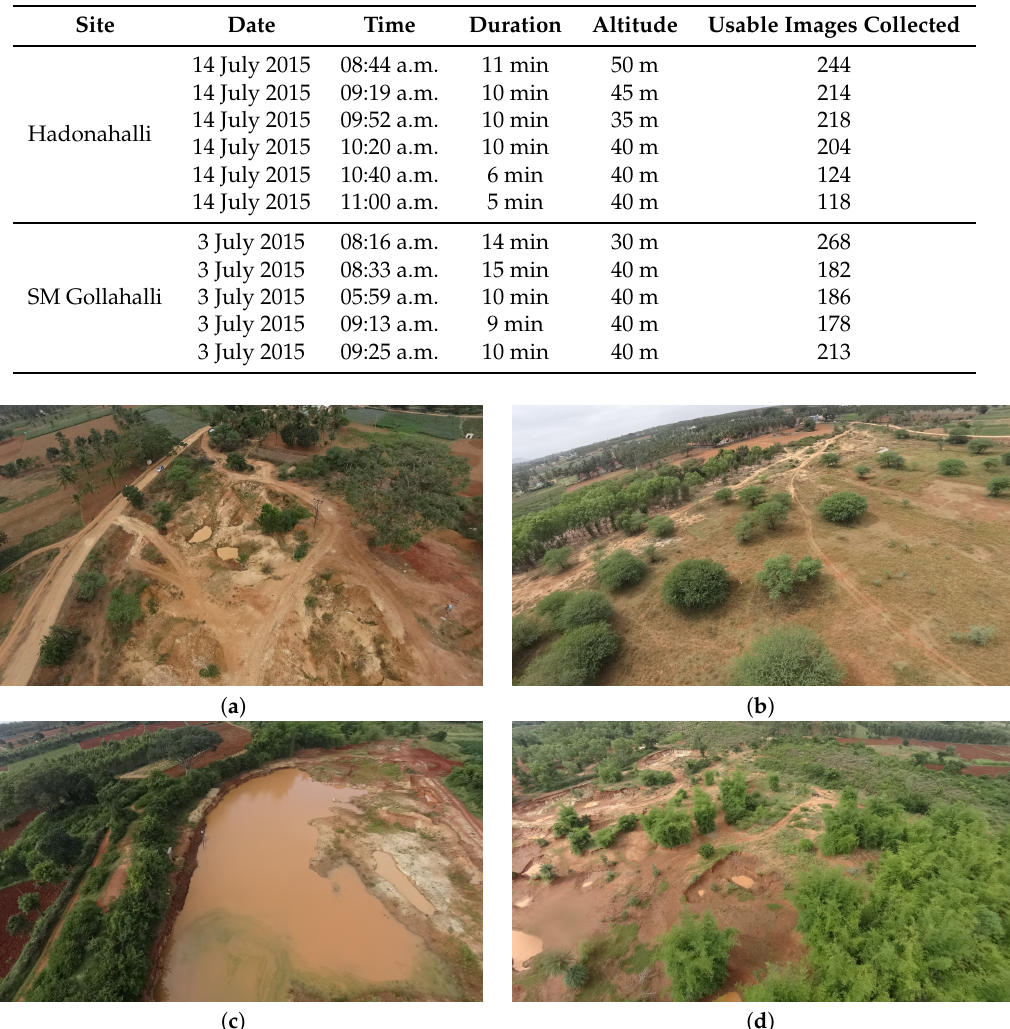
Table 1. Flight statistics at Hadonahalli and SM Gollahalli tanks. The UAV was set to a ground speed of 4 m/s for all flights. Images were considered “usable” if they were taken after the UAV hit the set altitude. Images recorded during takeoff and landing were discarded.